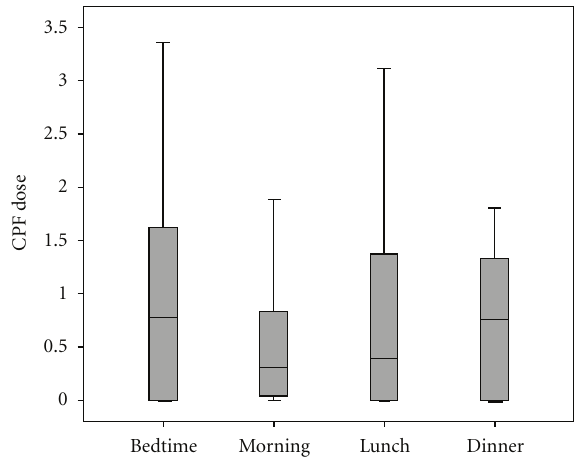
Figure 2: The dose estimates (CPF DOSE, µ g/kg/day) for chlor- pyrifos using 3,5,6-trichlorpyridinol concentrations in the spot urine samples collected at before bedtime in Day 1 and the first morning, lunch, and dinner voids in Day 2 as the SPK model